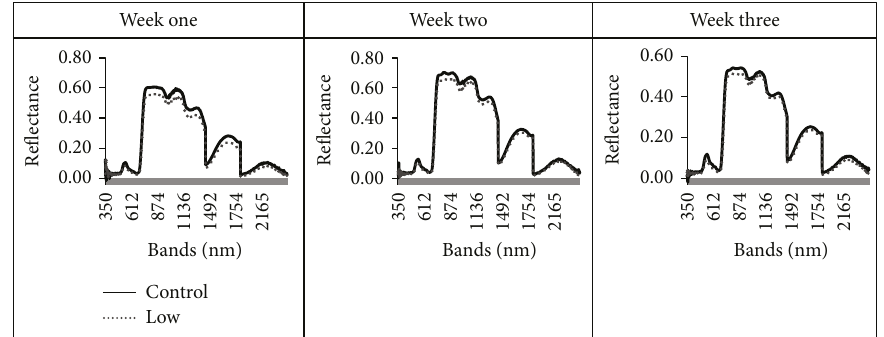
Figure 3: Re fl ectance spectra of healthy and low infested water hyacinth plants over three weeks of infestation (Adapted from Agjee et al. [24]). Table 1: RF classi fi cation accuracies for three simulated noise levels for three weeks of infestation. Noise (%)